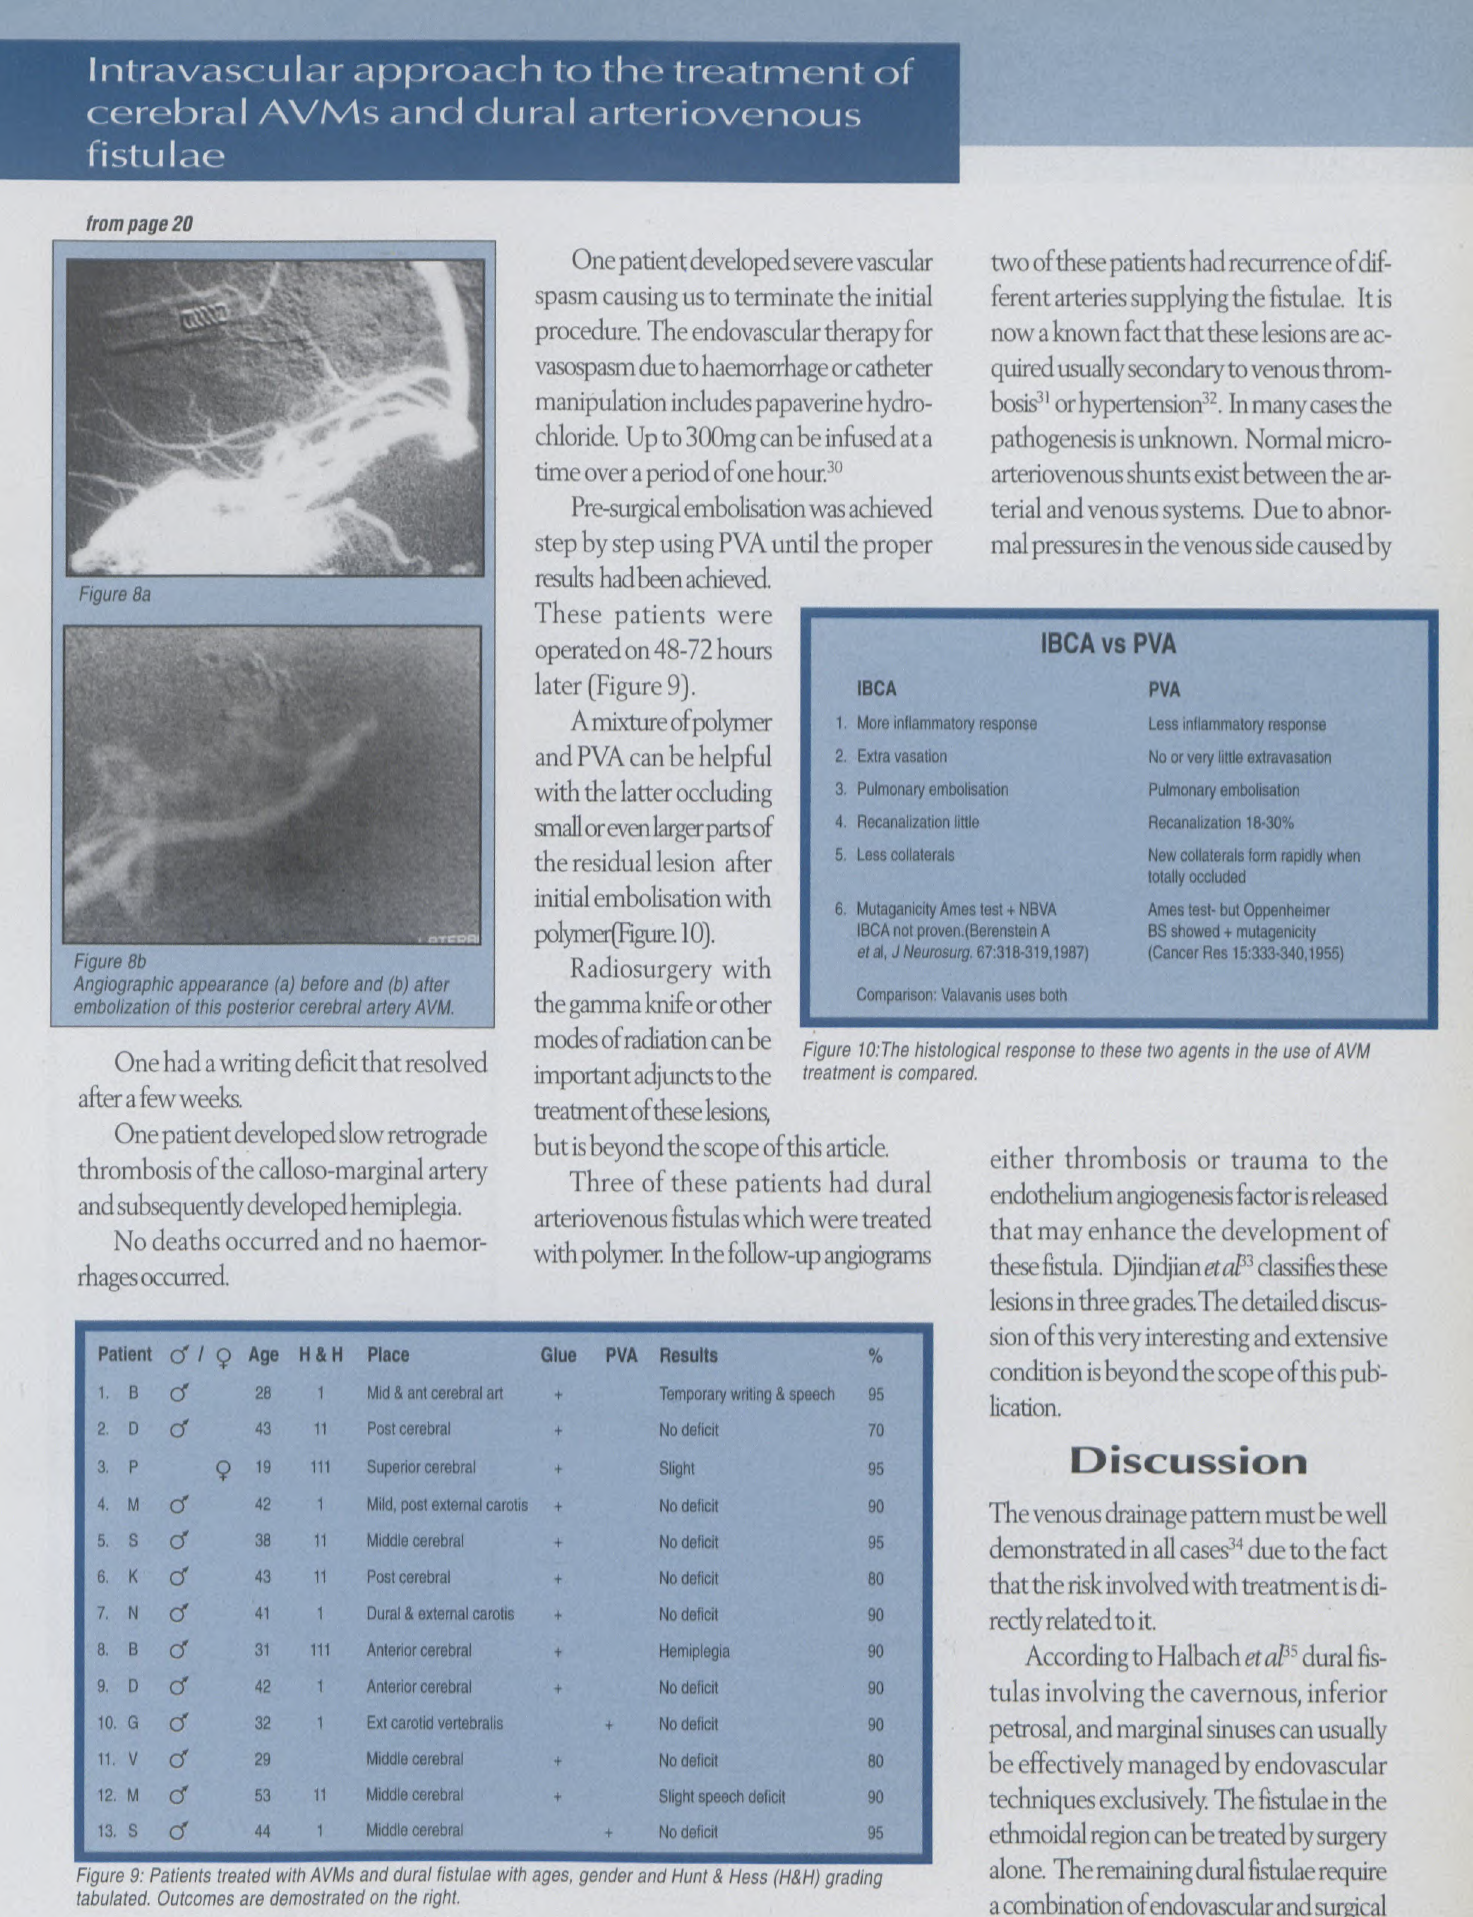
Figure 9: Patients treated wIth AVMs and dural fistulae wIth ages, gender and Hunt & Hess (H&H) gradmg tabulated. Outcomes are demostrated on the